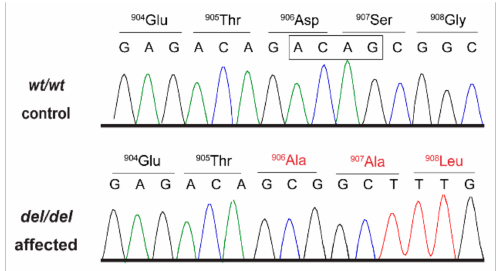
Figure 2. Details of the AKNA :c.2717_2720delACAG variant. Representative electropherograms of a control and an a ff ected dog are shown. The four deleted bases are indicated by the square. Altered amino acid translations are shown in